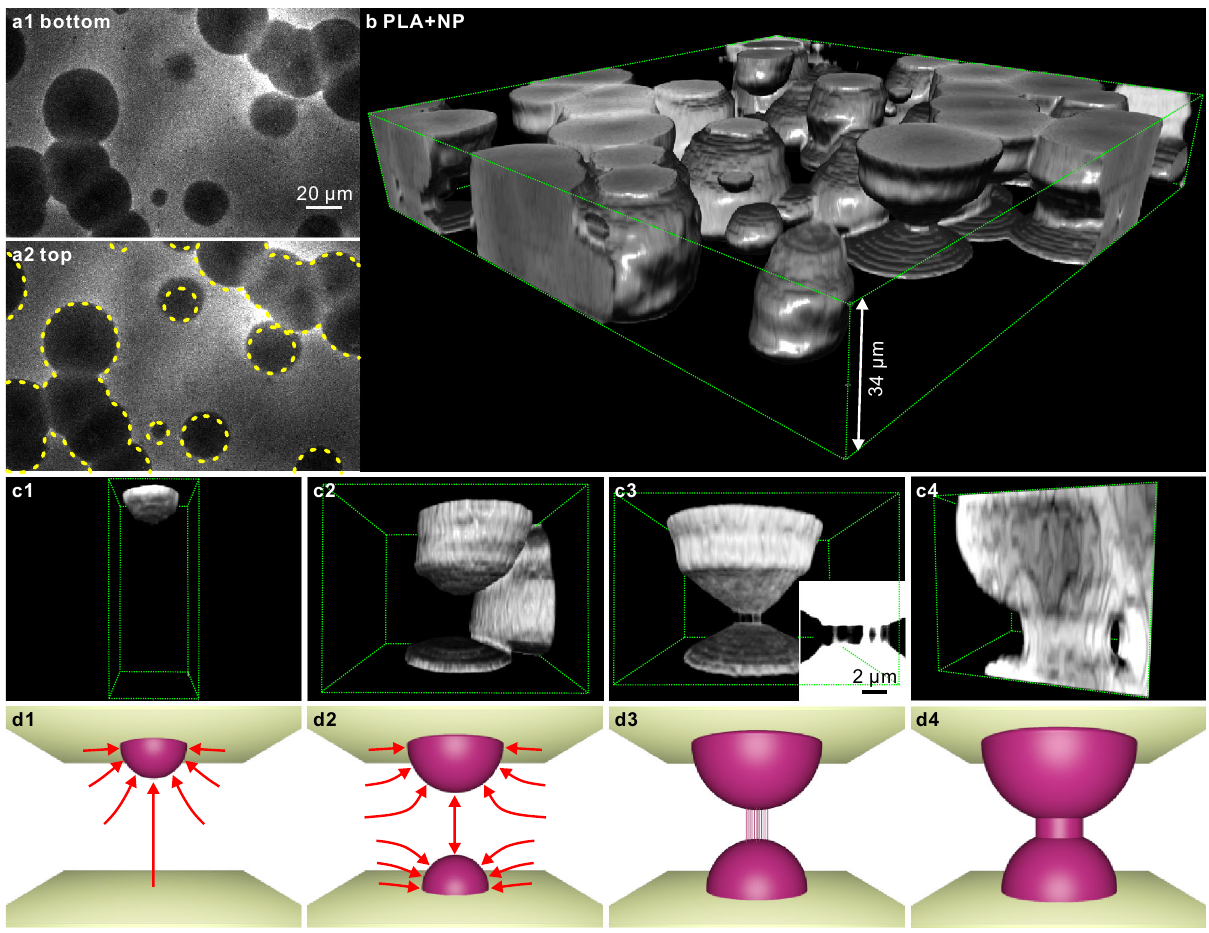
Fig. 5 Nucleation mirroring, shish-kebabs from “ quiescent ” melt and goblet morphology in PLA nanocomposite. PLA containing 1.3 wt% of 200 nm NR- labeled silica NPs was crystallized isothermally at T c = 130 °C; after 10 min spherulite growth was arrested by quenching in ice water. This applies to all panels in this fi gure. a z- slices ( a1 ) near the bottom and a2 near the top surface, illustrating nucleation mirroring across the sheet thickness; the dashed circles in ( a2 ) show the exact position of the spherulites directly opposite at the bottom surface seen in ( a1 ). b Surface rendering of arrested spherulite growth in a 34 µ m fi lm; the morphology resembles a treasure of ancient crockery. See also Supplementary Video 6. c Selection of images reconstructing different stages of formation of a “ goblet ” , starting with ( c1 ) a single spherulite, ( c2 ) formation of a second spherulite at the opposite (bottom) surface, ( c3 ) close approach of the two growing spherulites and the formation of bridging shish-kebabs, and fi nally, ( c4 ) formation of the goblet stand by multiplication and radial growth of the shish-kebabs or cylindrites. The inset in ( c3 ) is a section through the center of the goblet with inverted contrast (bright = low fl uorescence). Panels ( c1 – c4 ) actually show different coexisting regions of the sample. d1 – d4 Schematic representation of the four stages of goblet formation, roughly corresponding to ( c1 – c4 ), with the arrows indicating the approximate direction of melt fl ow (see also simulation in Fig.